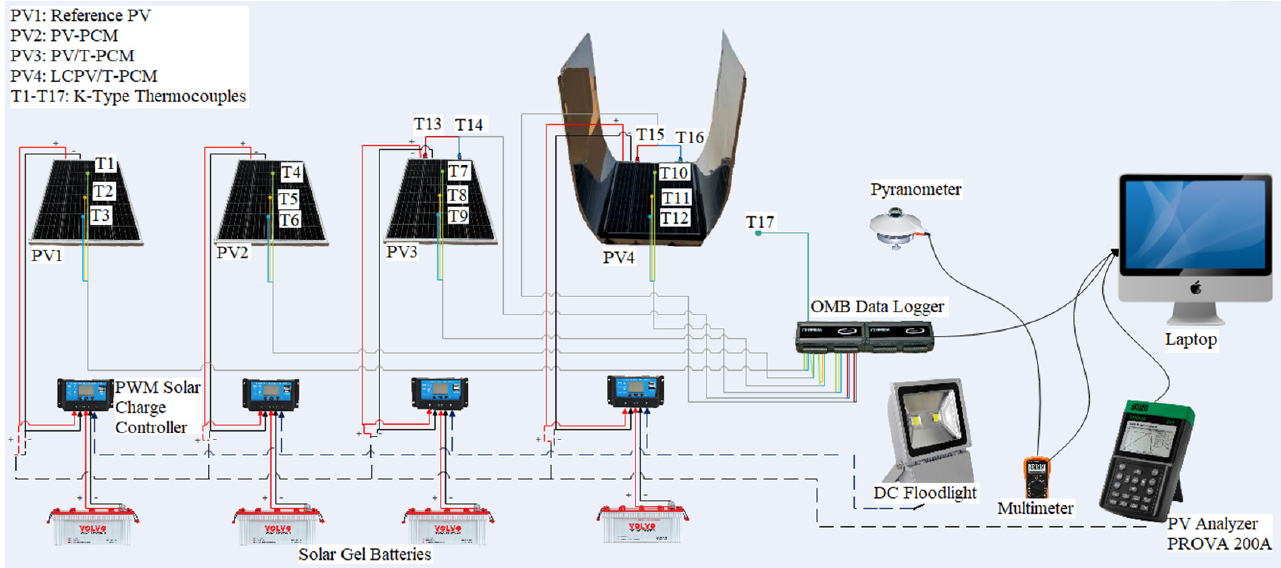
Figure 1. Schematic diagram of the system.